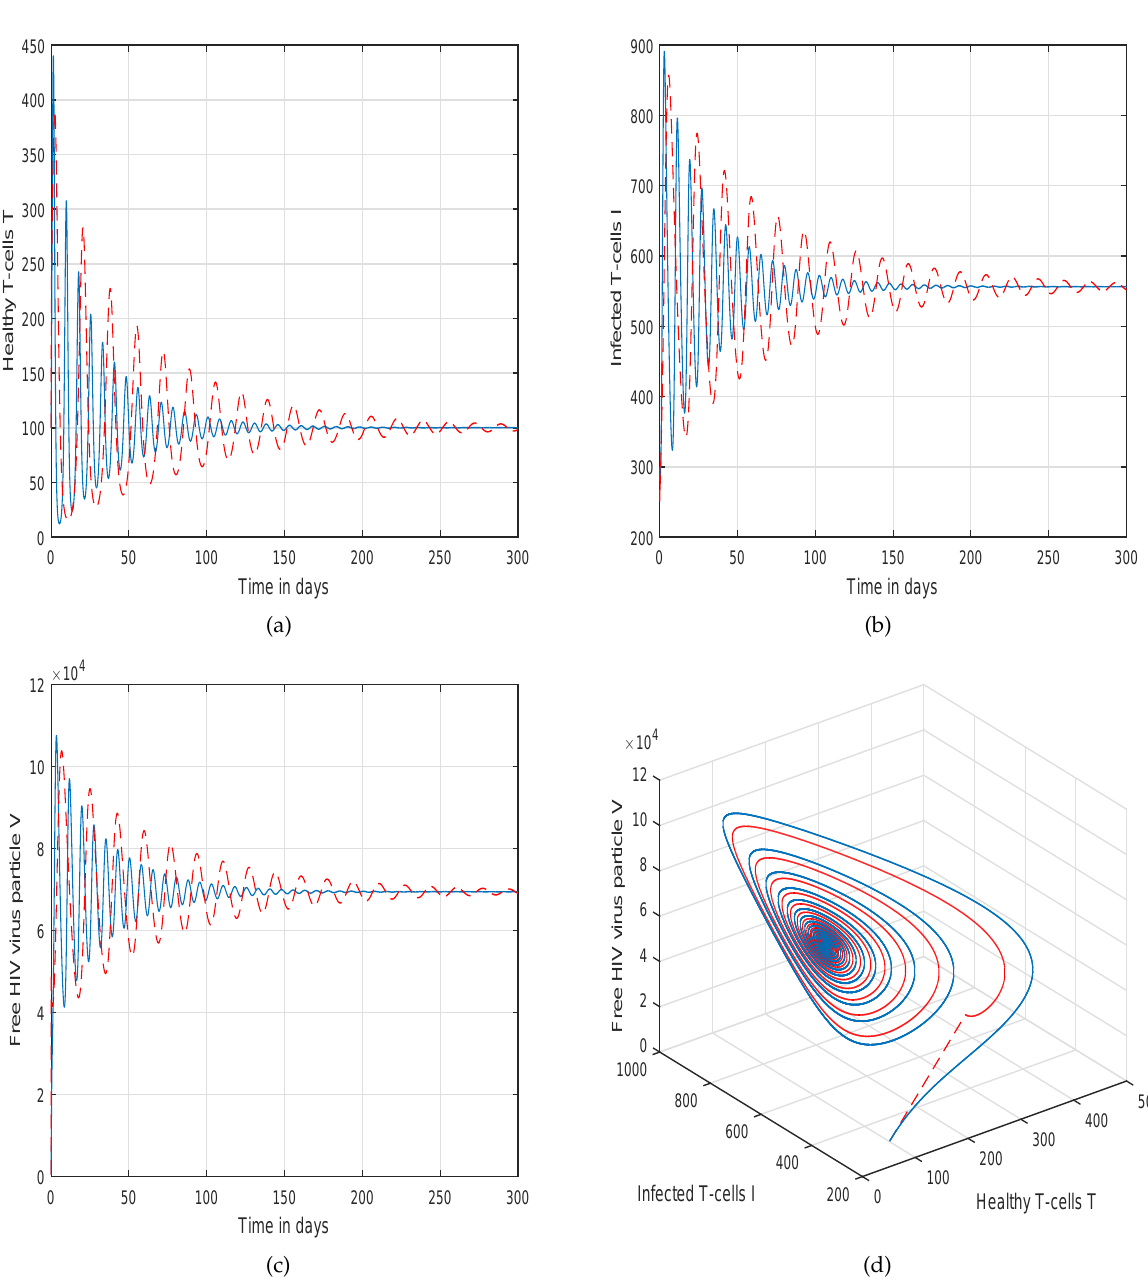
Figure 4. Illustration of the solution pathway of ( a ) healthy CD4 + T-cells, ( b ) infected CD4 + T-cells, ( c ) free HIV virus particles and ( d ) chaotic behavior of the proposed fractional model (2) of HIV infection with fractional-order ϑ =